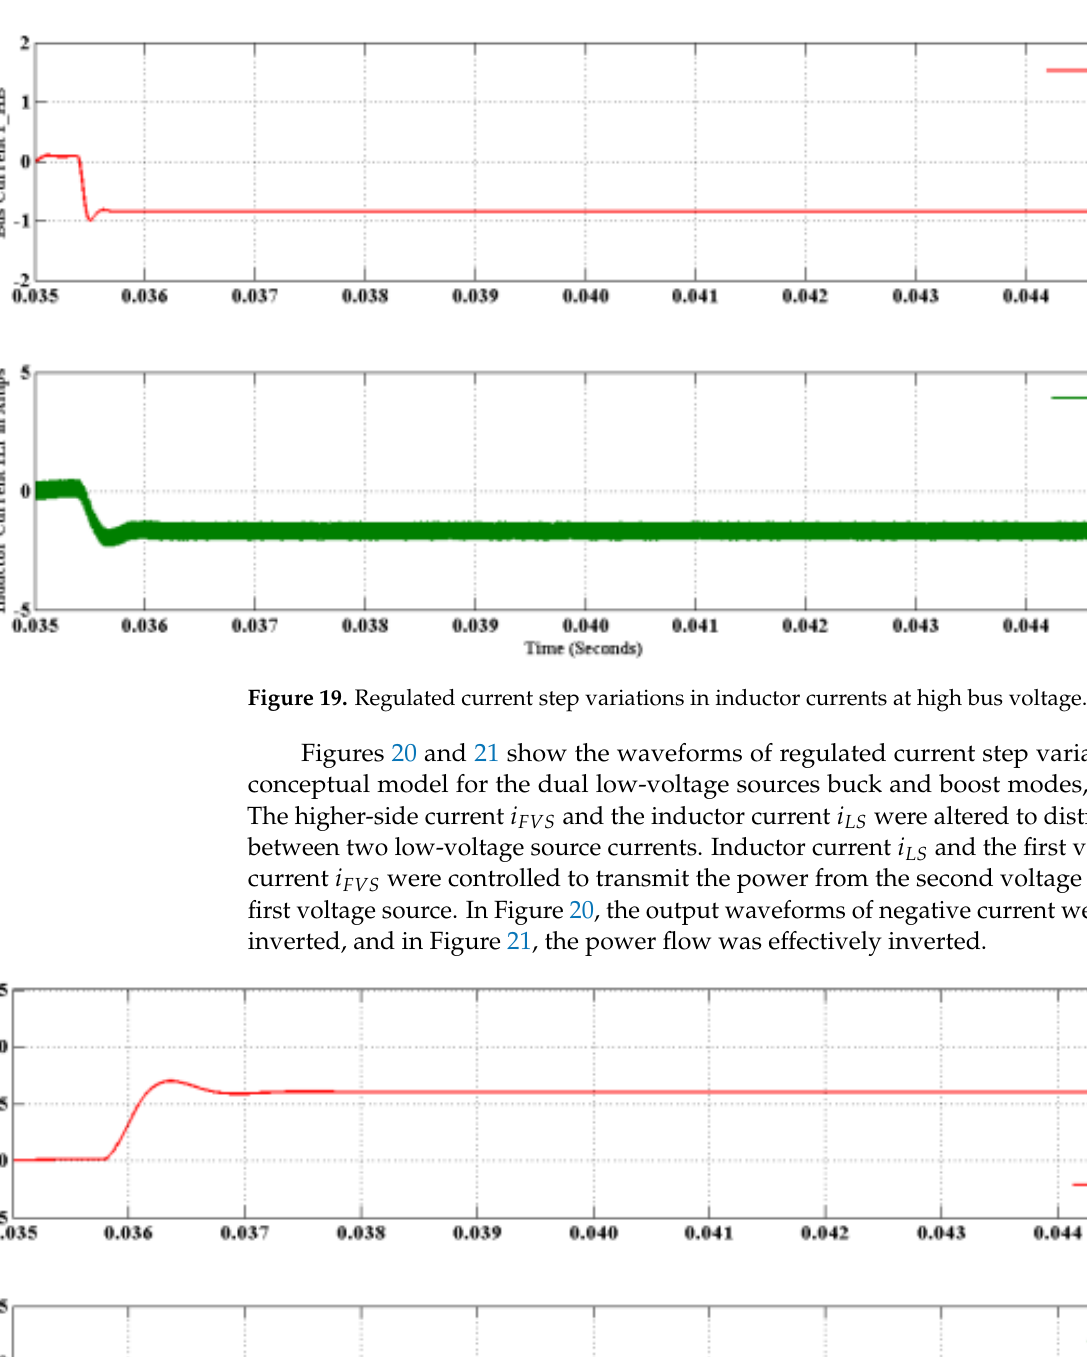
Figure 18. Regulated current step variations in inductor currents at dual low voltage sources.